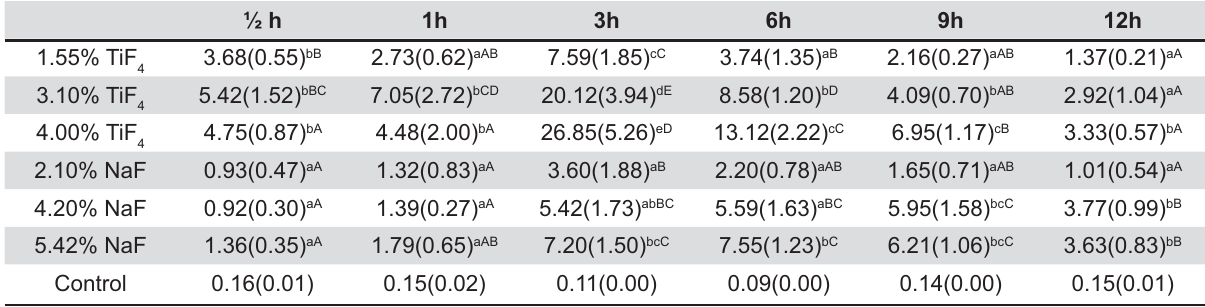
Table 1- (cid:2)(cid:3)(cid:4)(cid:5)(cid:6)(cid:2)>(cid:2)(cid:20)(cid:9)(cid:5)(cid:6)(cid:19)(cid:5)(cid:18)(cid:19)(cid:2)(cid:19)(cid:4)(cid:16)(cid:15)(cid:5)(cid:9)(cid:15)(cid:7)(cid:6)(cid:2)(cid:21)(cid:20)(cid:30)(cid:19)(cid:30)(cid:23)(cid:2)(cid:7)(cid:8)(cid:2)(cid:17)(cid:12)(cid:7)(cid:18)(cid:15)(cid:19)(cid:4)(cid:2)(cid:18)(cid:4)(cid:14)(cid:4)(cid:5)(cid:20)(cid:4)(cid:2)(cid:21)(cid:22)(cid:22)(cid:13)(cid:23)(cid:2)(cid:8)(cid:18)(cid:7)(cid:13)(cid:2)(cid:9)(cid:10)(cid:4)(cid:2)(cid:4)(cid:24)(cid:22)(cid:4)(cid:18)(cid:15)(cid:13)(cid:4)(cid:6)(cid:9)(cid:5)(cid:14)(cid:2)(cid:16)(cid:5)(cid:18)(cid:6)(cid:15)(cid:20)(cid:10)(cid:4)(cid:20)(cid:2)(cid:15)(cid:6)(cid:2)(cid:19)(cid:4)(cid:15)(cid:7)(cid:6)(cid:15)(cid:25)(cid:4)(cid:19)(cid:2)(cid:26)(cid:5)(cid:9)(cid:4)(cid:18)(cid:2)(cid:5)(cid:9)(cid:2) each time point